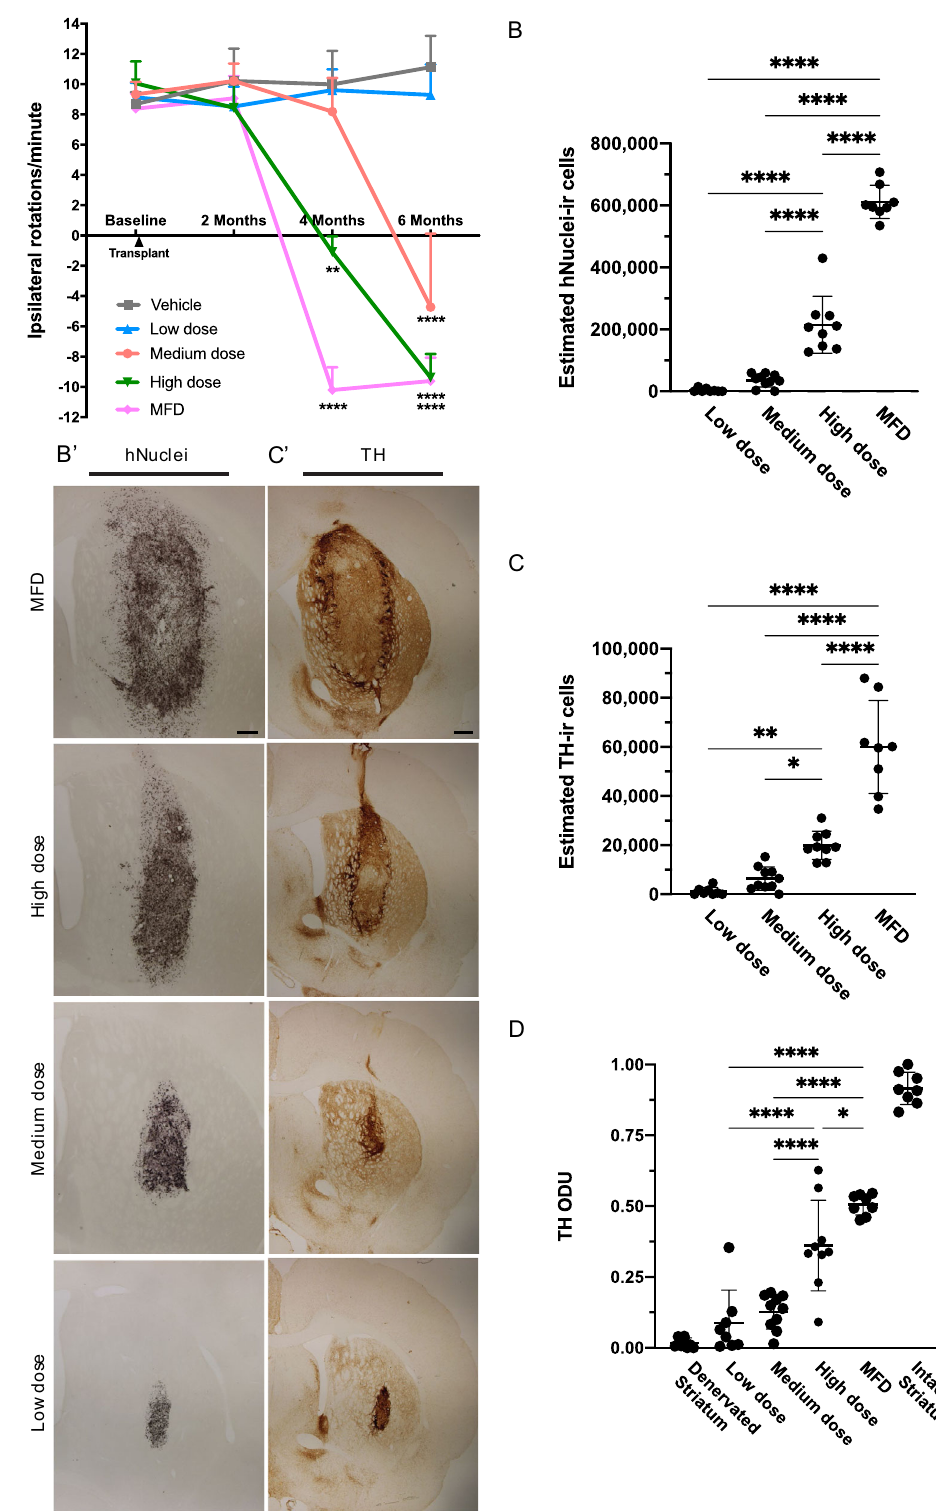
in the MFD, high, medium, and low dose groups, respectively (Fig. 6D). Signi fi cant differences were found when comparing MFD